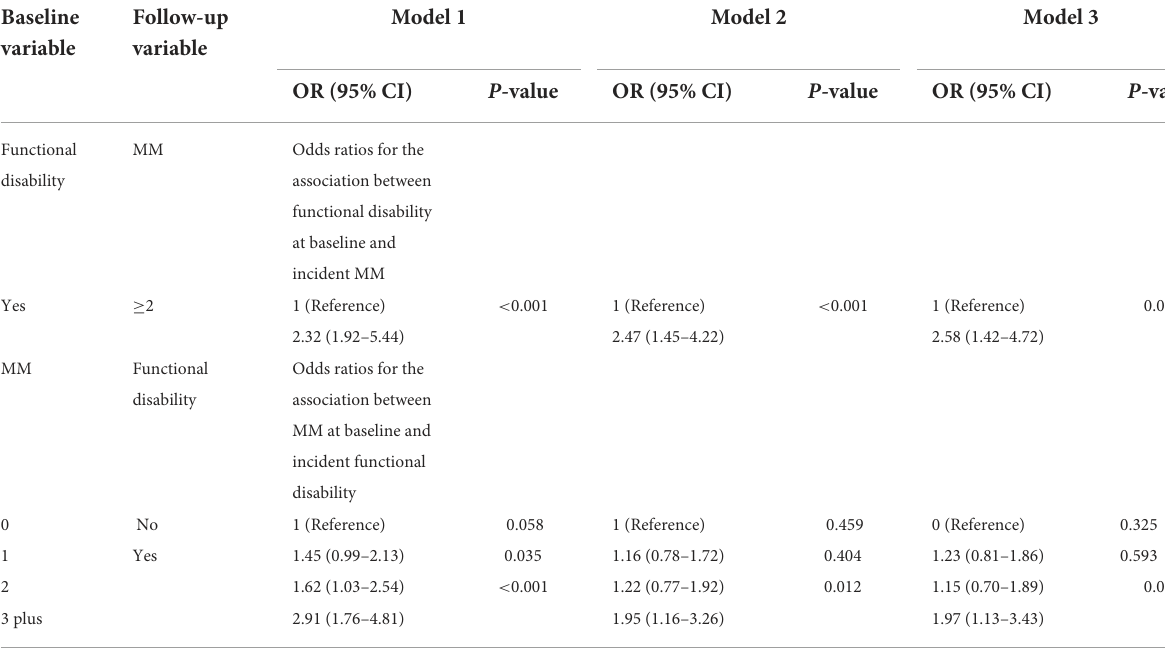
TABLE 4 Odds ratios for bidirectional associations between functional disability and multimorbidity (MM).